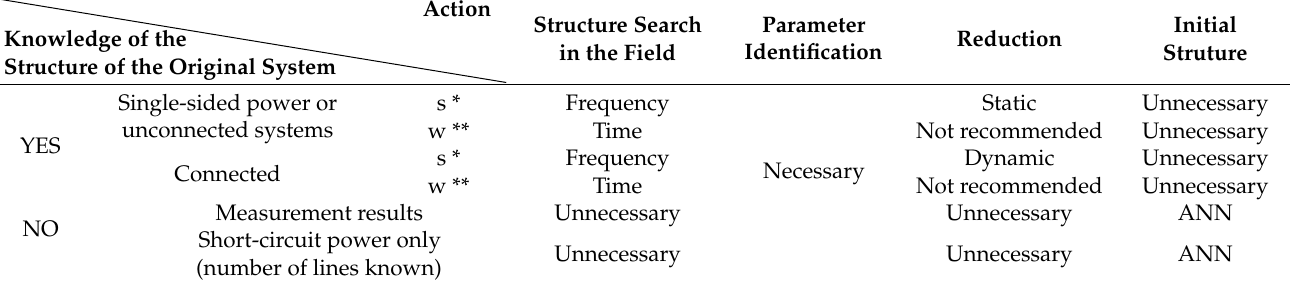
Table 1. Recommendations for equivalents when testing electromagnetic